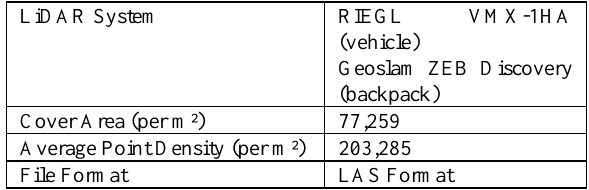
Table 3 . Description of Mobile LiDAR Data